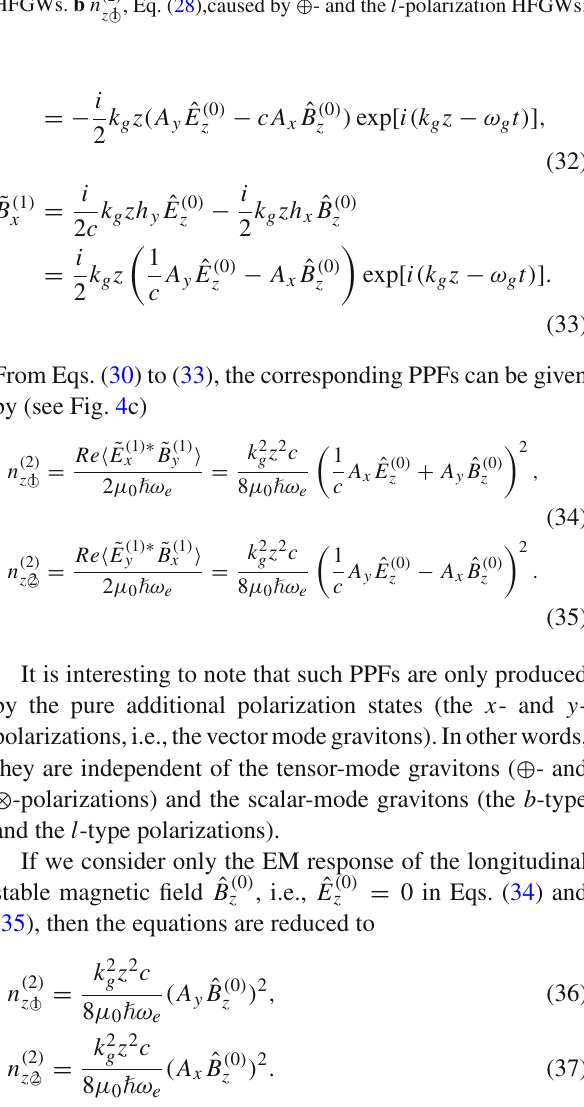
n ( 2 ) , Eq. (29), caused only by x -polarization HFGWs. c n z 2 (cid:9) Eqs. (34) and (35), caused by x - and y -polarization